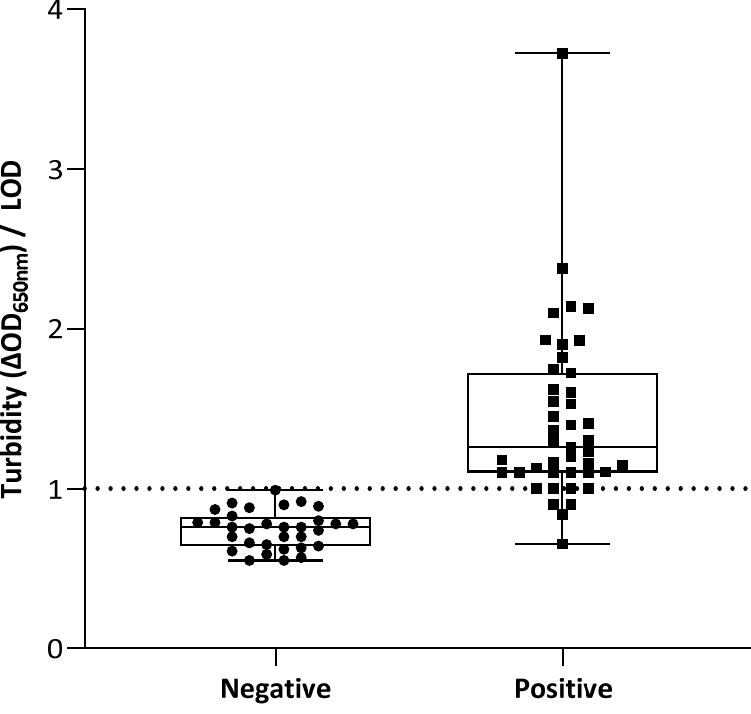
Figure 2. Molecular MFEA readout for DENV RNA( − ) and DENV RNA(+) plasma samples. Negative plasma from donors ( n = 32) and positive plasma samples from patients ( n = 43) were assayed. The turbidity signal is expressed as the difference of optical density at 650 nm ( ∆ OD 650nm ) measured before and after the three magnetization cycles. The limit of detection (LOD) is taken as the mean value of blank samples plus three